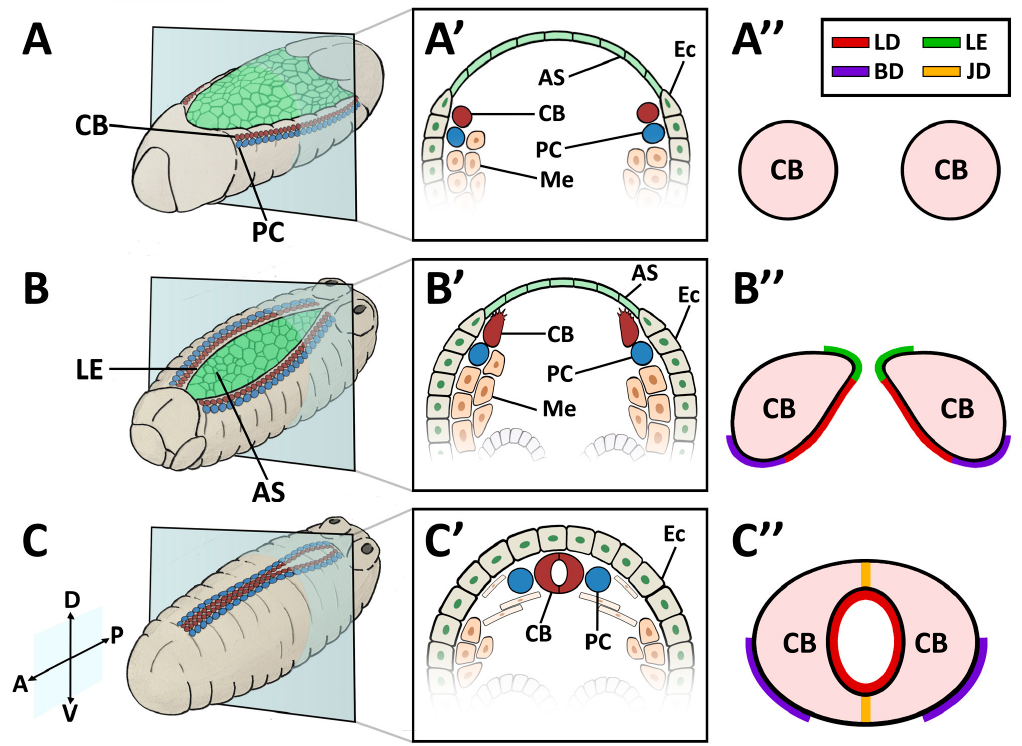
Figure 1. Cardioblast (CB) migration during Drosophila embryogenesis. ( A–A” ) Stage 12–13 embryo. ( A ) Perspective view of a whole embryo showing cardiac precursor cells associated with the dorsal ectoderm prior to dorsal closure; ( A’ ) Cross-sectional impression showing the lateral-most mesodermal cells, which have become specified as CB precursors; ( A” ) CB precursors prior to the extension of the motile apical domain. ( B–B” ) Stage 14–15 embryo. ( B ) Lateral ectoderm and CBs migrate dorso-medially and displace the amnioserosa; ( B’ ) Cross-sectional impression showing Leading Edge activity. CBs extend a motile apical domain towards the midline; ( B” ) CBs assume a teardrop shape with the Cadherin-rich apical domain forming a Leading Edge. The basal domain is quiescent. The pre-luminal domain localises Dystroglycan, β PS-Integrin, Multiplexin, and the Slit-Robo complex. ( C–C” ) Stage 17 embryo. ( C ) CBs make contralateral contact at the midline upon dorsal closure. ( C’ ) Cross-sectional impression showing paired CBs at the dorsal midline, flanked by PCs; ( C” ) Formation of the heart tube. CBs form a dorsal and ventral seam at the Cadherin-based junctional domain to enclose a lumen. Dorsal at top. A: anterior; AS: amnioserosa; BD: basal domain; CB: cardioblast; D: dorsal; Ec: ectoderm; JD: junctional domain; LE: Leading Edge; LD: luminal domain; Me: mesoderm; P: posterior; PC: pericardial cell; V: ventral.